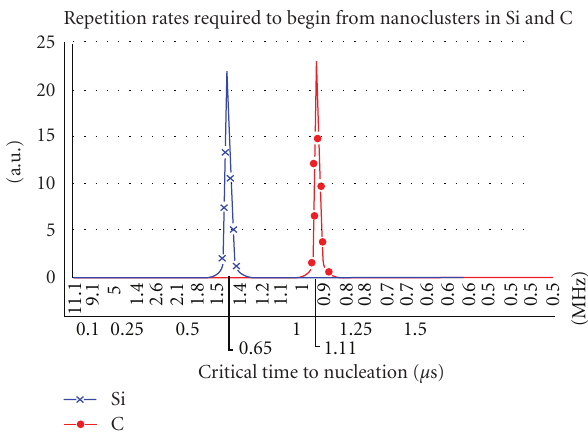
Figure 7: Critical time to nucleation in microsecond and repetition rate is in